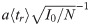
Dependence of the fit parameters a〈tr〉I0/N-1 and I0/N on the average clustering.Dashed lines are intended to guide the eye through the data points.